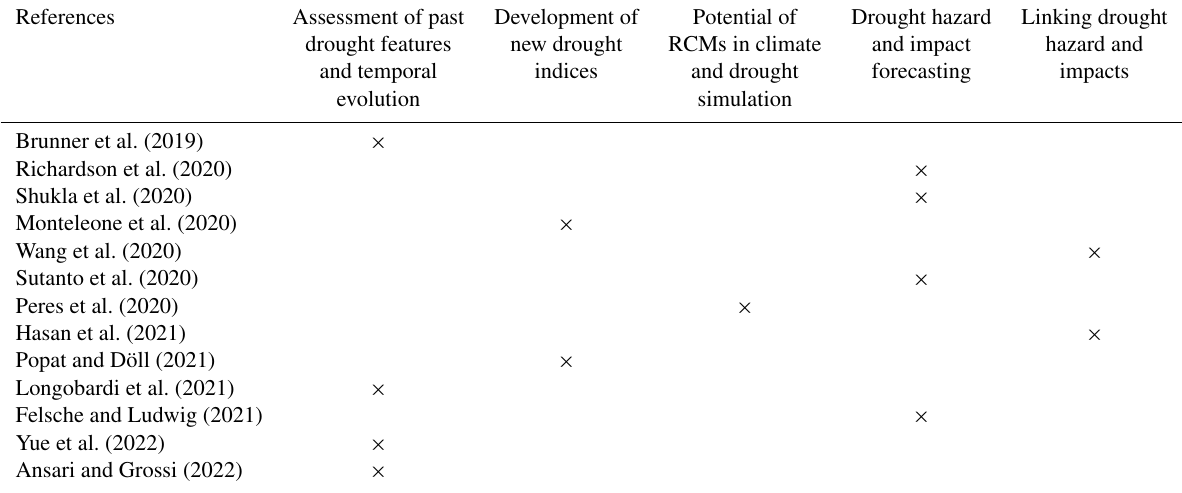
Table 1. Main topics of the special issue